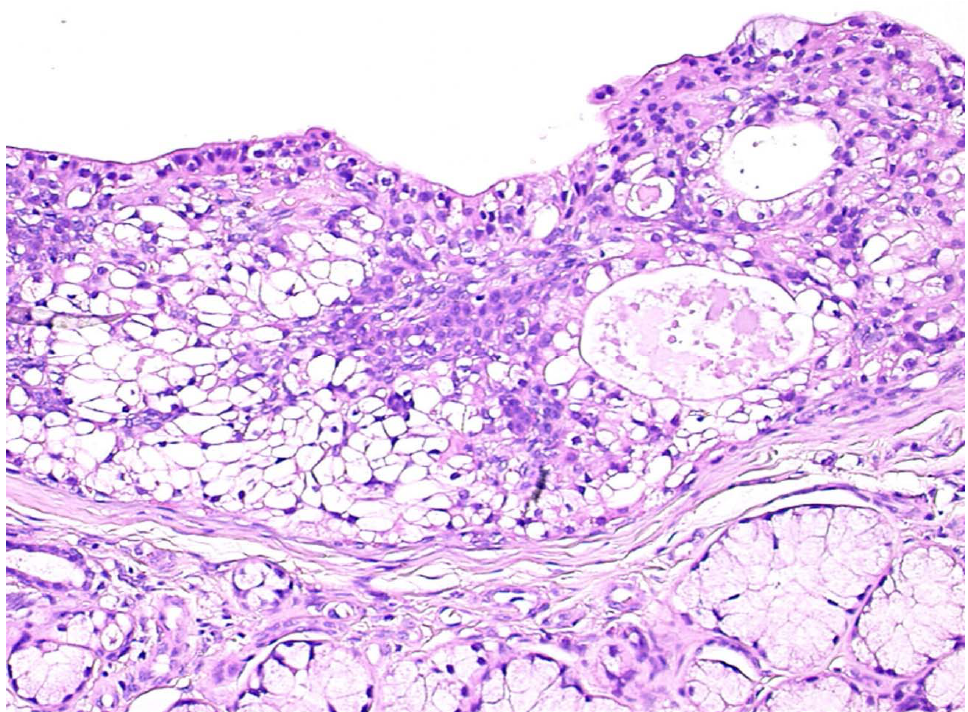
Figure 3. The epithelial component consisted of small columnar and intermediate cells, cells with prominent cytoplasmic clearing, rare flat to polygonal cells showing epidermoid differentiation and a reduced number of large mucous ‐ producing cells with multivacuolated cytoplasm. (H&E, x10).